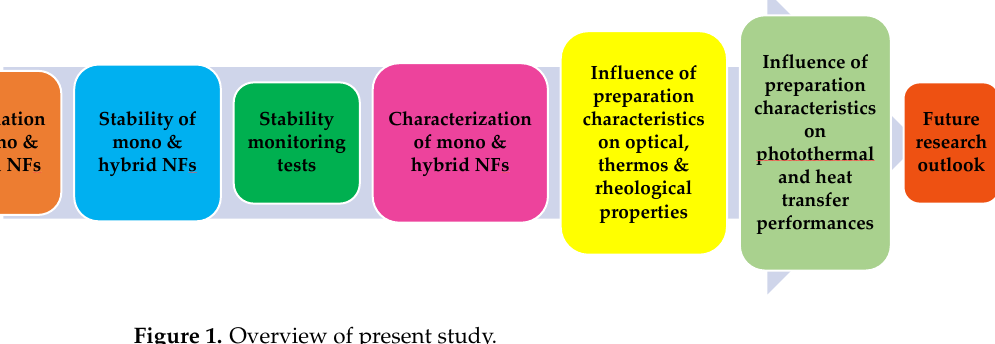
Figure 1. Overview of present study.